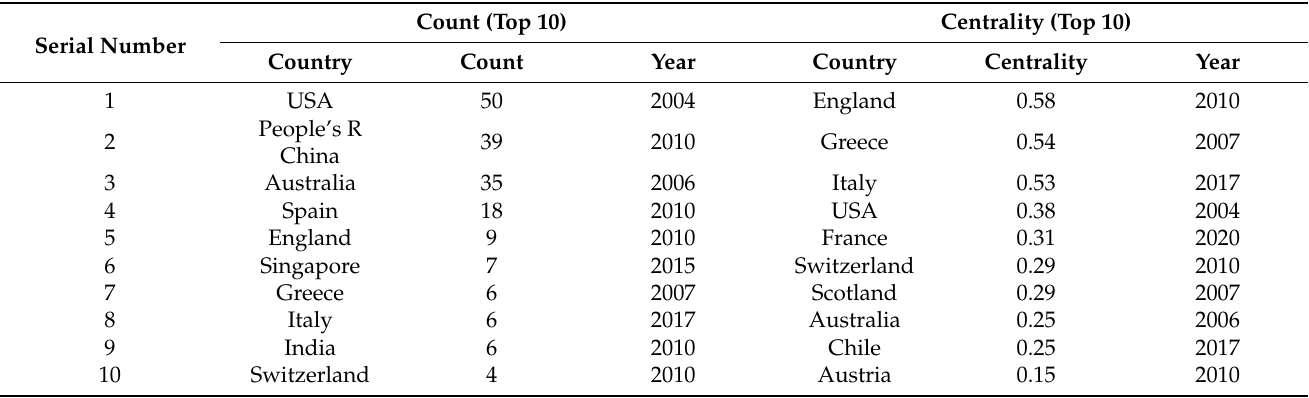
Table 1. Statistics of national cooperative publishing (Top